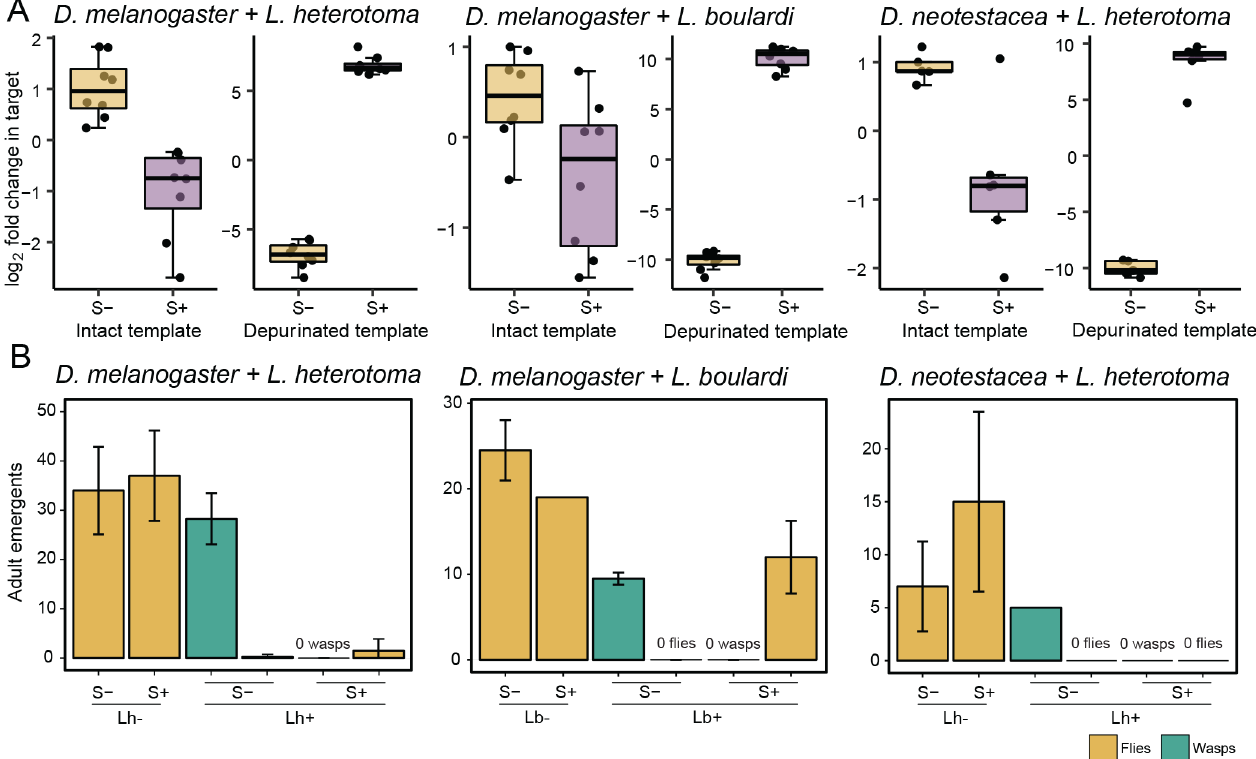
Fig 1. Parasitic wasp ribosomes are depurinated during host protection. Levels of intact and depurinatedwasp ribosomes are significantly decreased and increased,respectively,in Spiroplasma -positiveflies, comparedto Spiroplasma -negativeflies (A). Results of t-tests for intact ribosomes: D . melanogaster + L . heterotoma , p < 0.001; D . melanogaster + L . boulardi , p = 0.028; D . neotestacea + L . heterotoma , p = 0.010, and for depurinatedribosomes, all fly-wasp pairs, p < 0.001; n = 8, 8, 6, and 5 flies per treatment, for D . melanogaster S+ , S-, and D . neotestacea S+ , S-, respectively.Jitter points are the mean of two technicalreplicates per wasp-infested larva. Outcomes of wasp exposure for fly and wasp survival were measuredas emerged adults (B). Each strain of Spiroplasma kills Leptopilina . L . heterotoma and L . boulardi emergenceis significantly reducedin Spiroplasma -positiveflies relativeto Spiroplasma -negativecontrols (t-tests, L . heterotoma in D . melanogaster , p < .001; L . boulardi in D . melanogaster , p = .003; L . heterotoma in D . neotestacea , p < .001). Y-axes are labeledwith total number of adult emergentsper dish and error bars show the standard deviationof the mean number of adult emergentsacross replicatedishes (sample sizes: L . heterotoma in D . melanogaster , 60 larvae, 4 dishes; L . boulardi in D . melanogaster , 40 larvae, 2 dishes; L . heterotoma in D . neotestacea , 40 larvae, 2 vials).